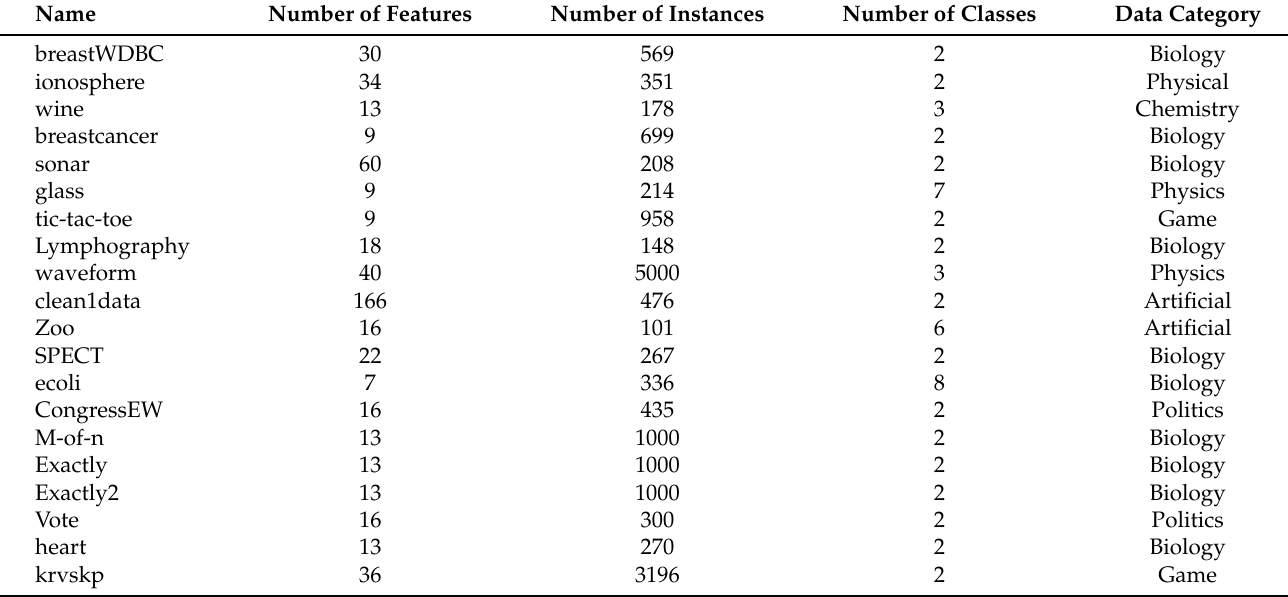
Table 1. Description of the benchmark datasets.